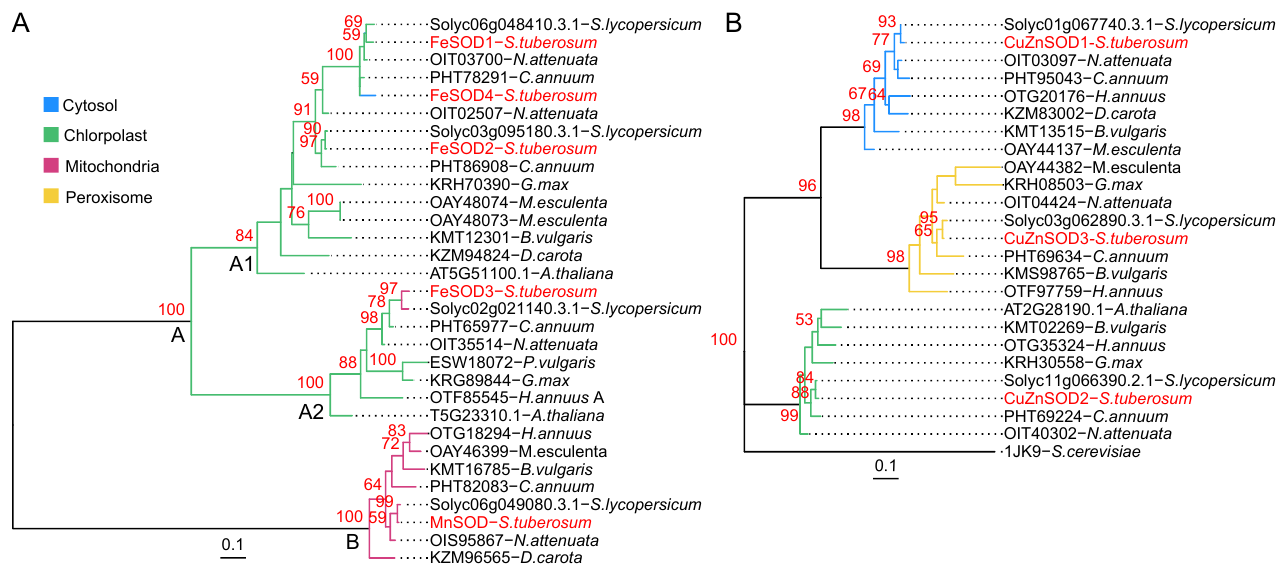
Figure 6. Maximum likelihood phylogenetic trees of StSODs. ( A ) Midpoint rooted Mn-FeSOD phylogenetic tree. ( B ) Rooted CuZnSOD phylogenetic tree. Support values were obtained us- ing 100 iterations of non-parametric bootstrap; values over 50/100 are indicated with a red num- ber. Clade/tip coloring is based on subcellular location (color legend) obtained using Light Attention